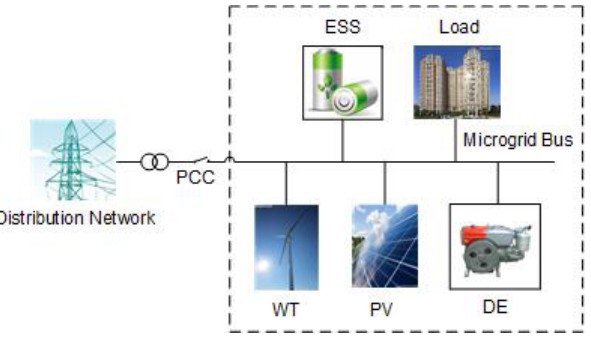
Figure 1. The structure diagram of the